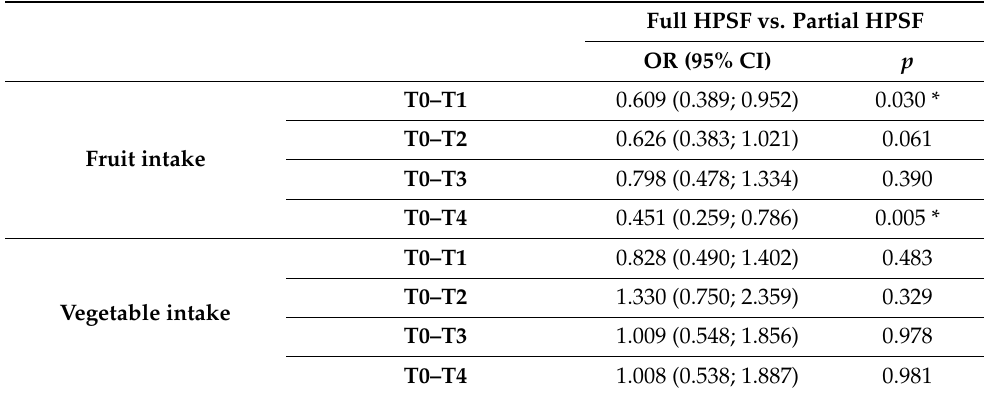
Table 5. Estimated intervention effects on fruit and vegetable